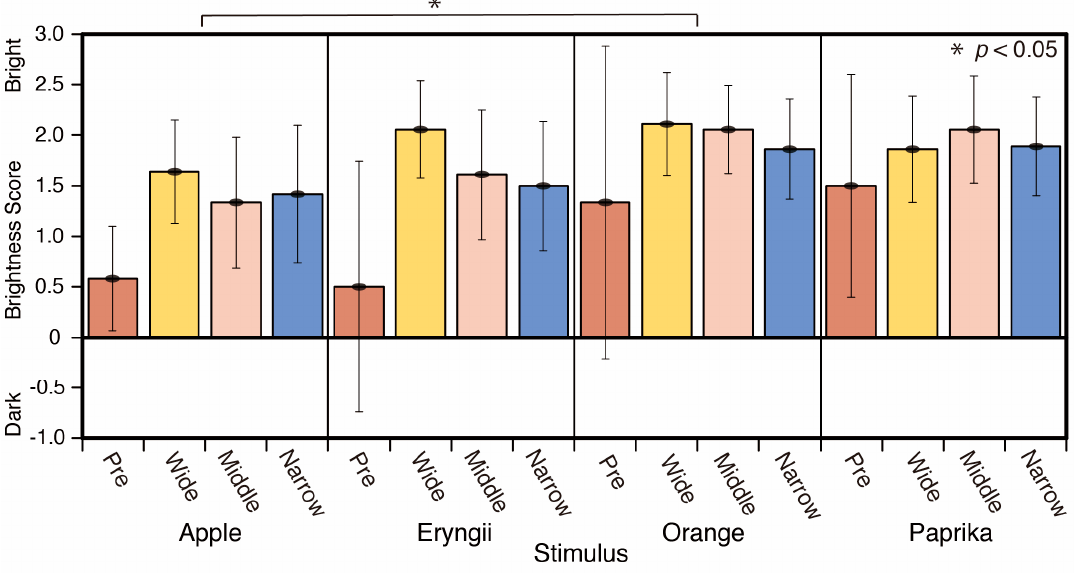
Figure 16. Brightness scores and stimulus.